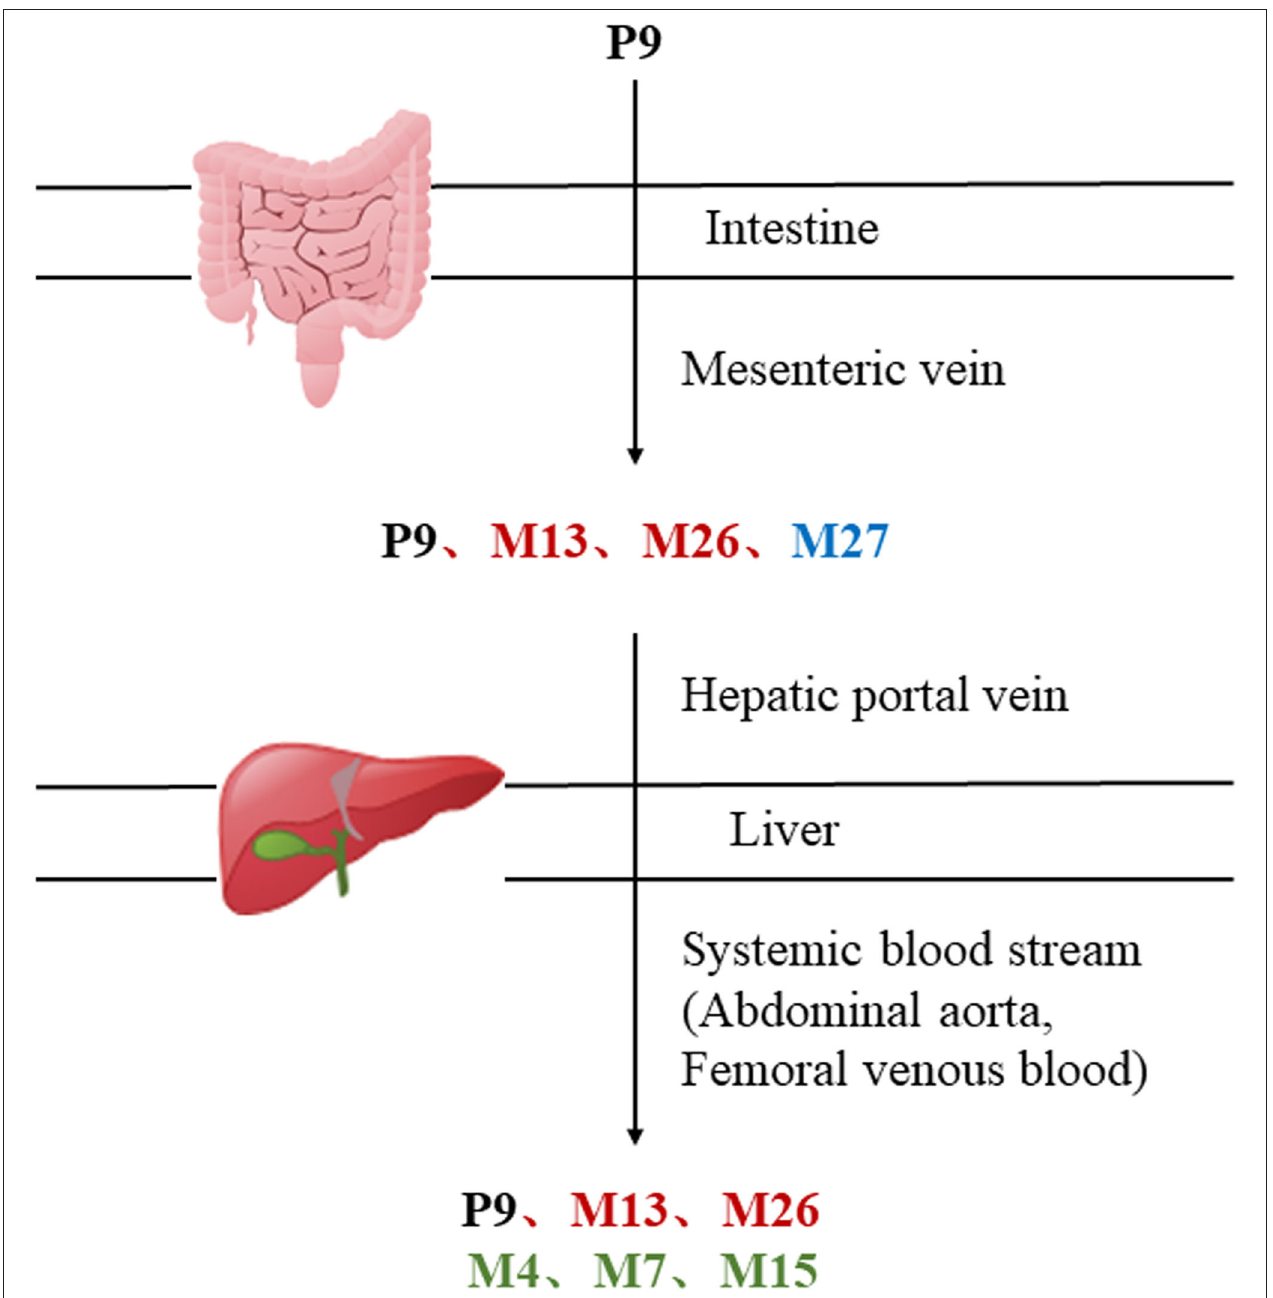
FIGURE 2 | The sequential process of paeoniflorin in the digestive system.